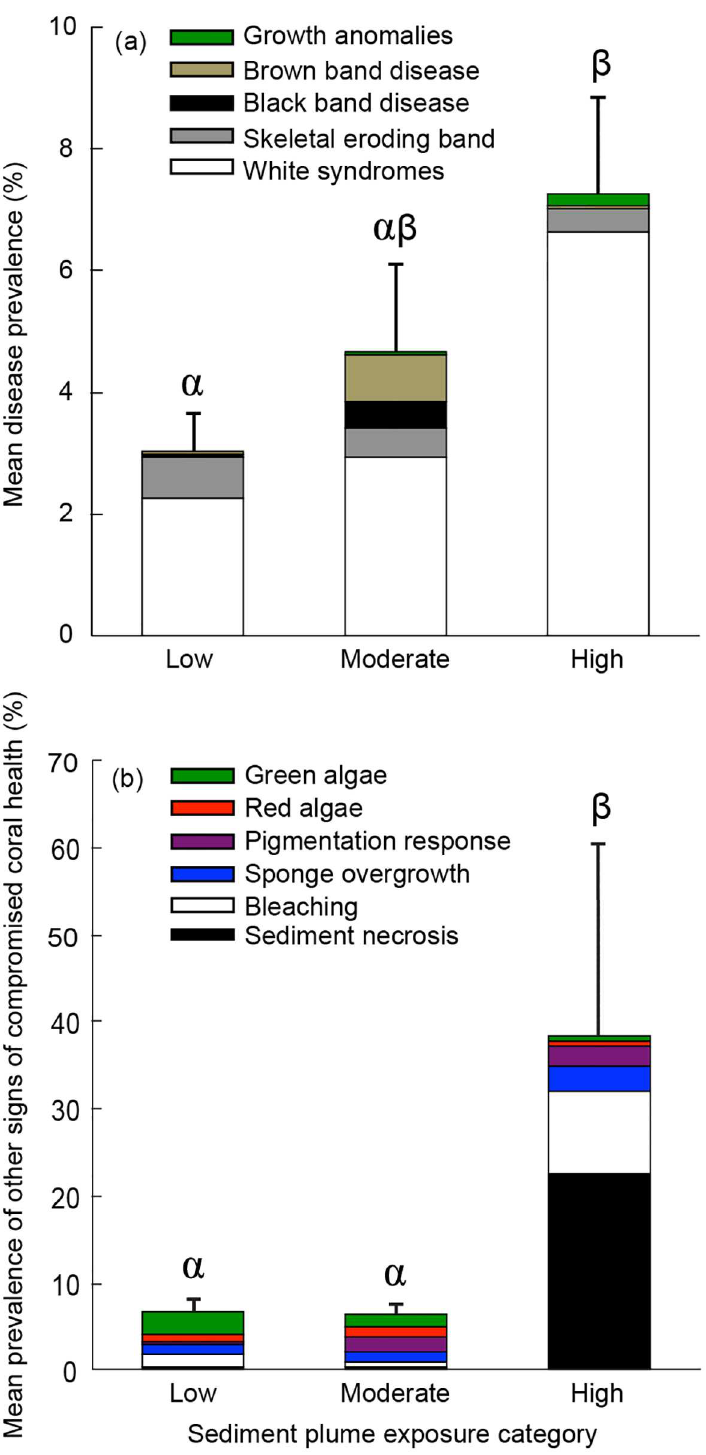
Fig 2. Mean prevalence of (a) coral disease and (b) other signs of compromised coral health at sites within three sediment plume exposure categories: low (0 to 9 plume exposure days; n = 18 transects), moderate (40 to 78 plume exposure days; n = 9 transects),and high (296 to 347 plume exposure days; n = 6 transects). Stacked bars indicate disease or other compromised coral health indicator prevalence by category and error bars indicate standard error among transects for total